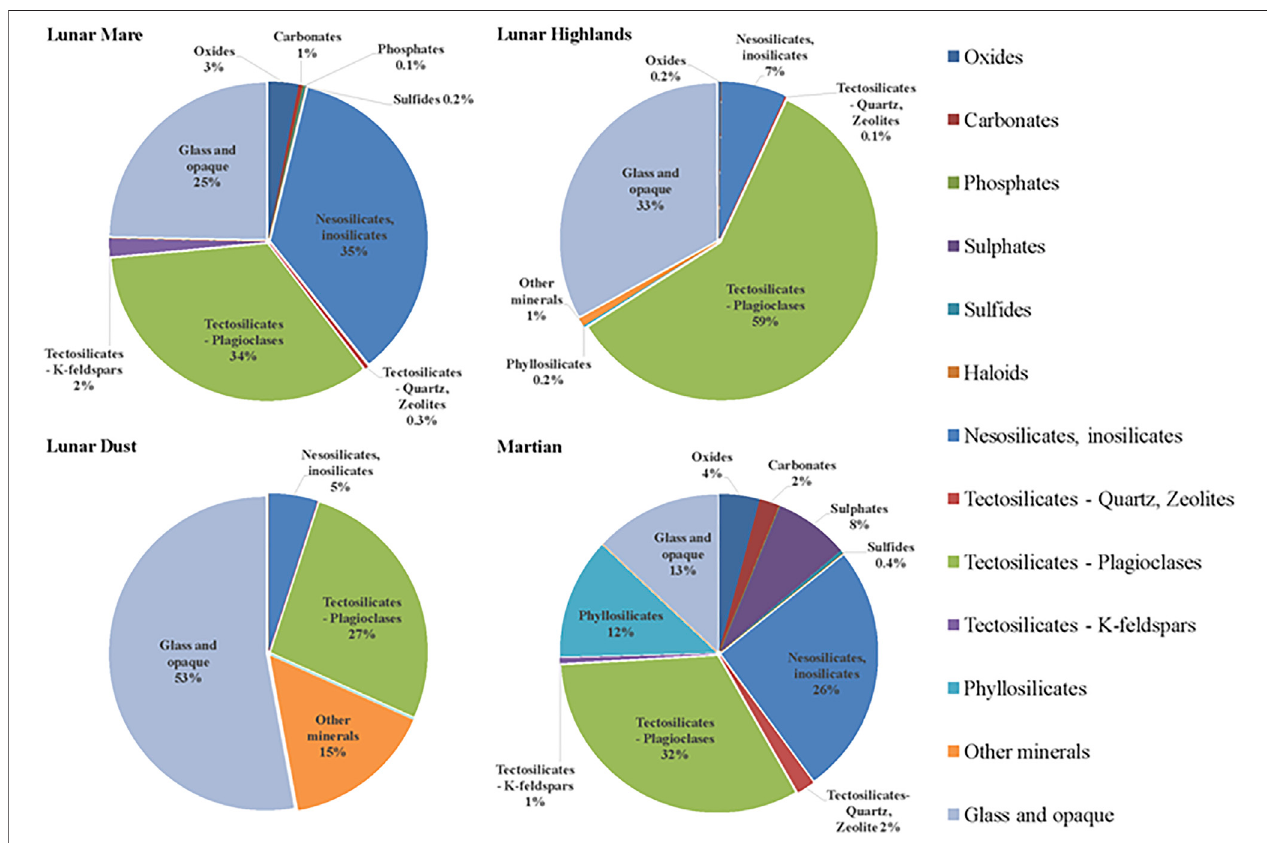
FIGURE1| Dataofthe fi gurearerelativeonlytosimulants(19/30)whosemineralogicalcompositionisreportedformorethan73%ofthetotalmassintheliterature ( Supplementary Table S1 ). The mineralogical classes are split as follow: Oxides (Ilmenite; Magnetite; Ti-magnetite; Hematite; Ferrihydrite; Cr-spinel); Carbonates (Calcite; Fe-carbonate; Mg-carbonate); Phosphates (Apatite); Sulphates (Gypsum; Selenite; Mg-sulfate; Anhydrite); Sul fi des (Pyrrhotite; Sul fi de); Nesosilicates — inosilicates (Olivine + pyroxene + ilmenite; Olivine; Clinopyroxene; Augite; Enstatite; Pyroxene + Hornblende; Pyroxene; Diopside; Hypersthene); Tectosilicates — Quartz,Zeolite;Tectosilicates — Plagioclases(Plagioclase;Anorthite;Albite;Labradorite);Tectosilicates — K-feldspars(Sanidine;K-feldspar;Orthoclase); Phyllosilicates (Smectite; Saponite; Chlorite); Other minerals (undifferentiated). Glass + opaque (Plagioclase glass, basaltic glass, hydrated silica, Volcanic glass; Glass; Opaque + Glass).